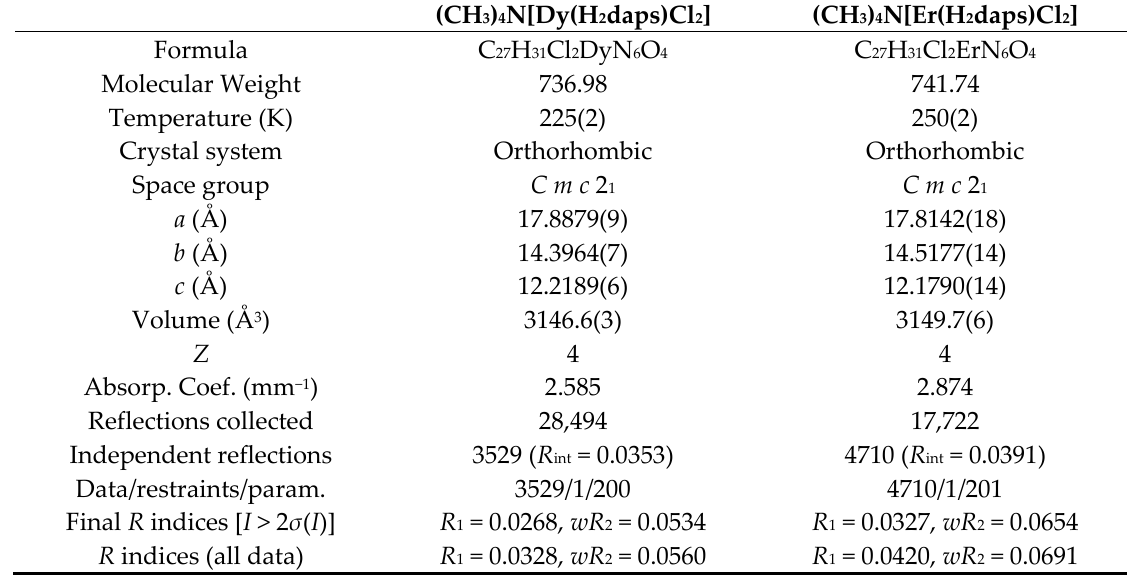
Table 1. Crystal data and structure refinement for DyH 2 daps and ErH 2 daps